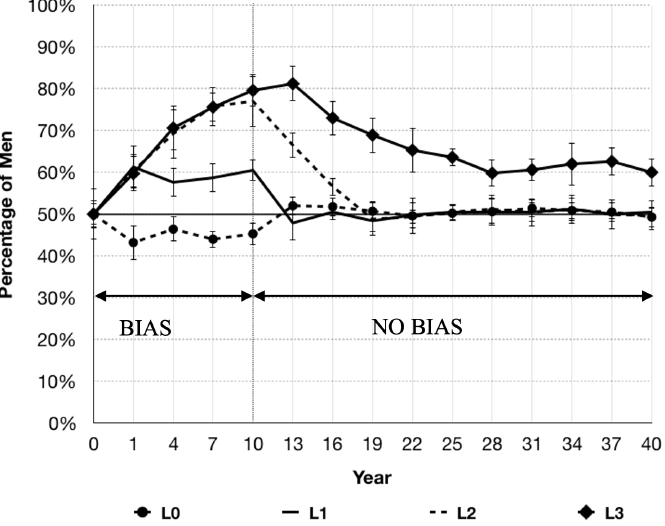
Figure 7. Gender balance across all four levels during a 40-year simulation that starts with a promo- tion bias of 0.3, which drops to 0.0 after 10 years.